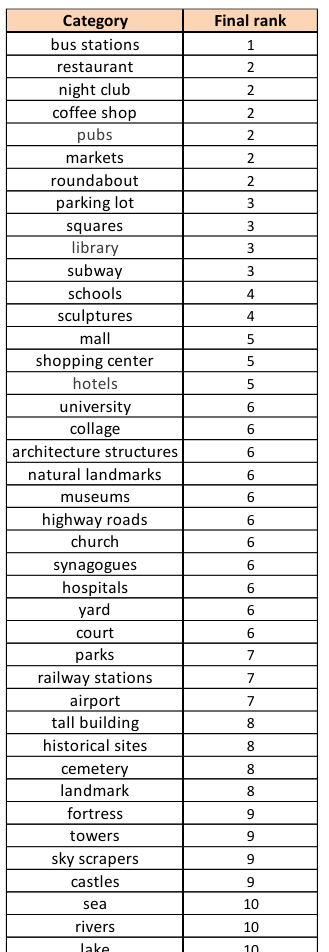
Figure 3. The route from an origine point A to a destination point B is segmented by intermediate points, and Wikipedia querys are performed on these points